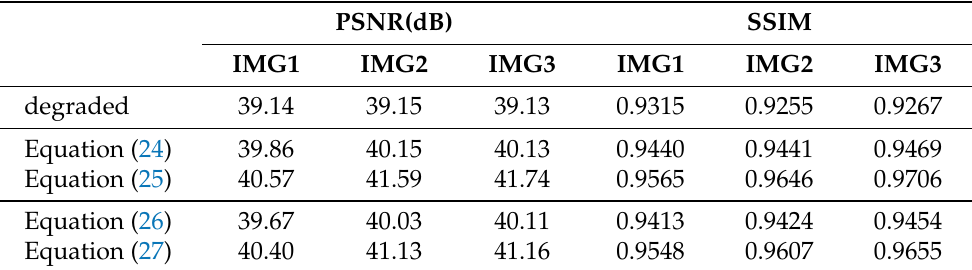
Table 4. Thermal image denoising using synthesized images with the four regularization strategies. Performances of each regularizer have been measured by four image assessments: PSNR and